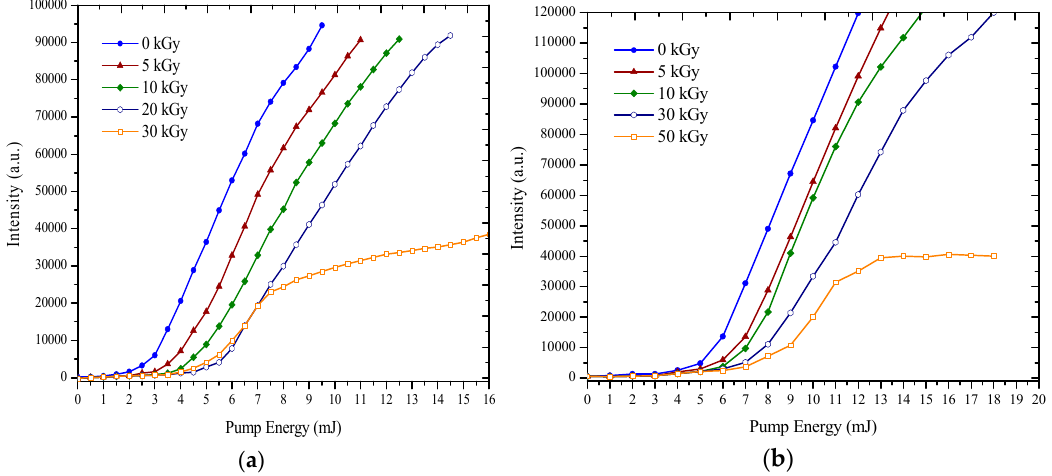
Figure 6. Cont. Figure 6. ( a ) The relationship between Pump Energy (mJ) vs. Intensity (a.u.) for MEH–PPV in THF at a 50 μ M concentration for different dose ranging from 5 to 30 kGy; ( b ) The relationship between Pump Energy (mJ) vs. Intensity (a.u.) for BMP in THF at 5 mM concentration for different dose ranging from 5 to 50 kGy. Table 1. ( a ) The details of BMP fluorescence, ASE peak wavelength (nm), peak intensity (a.u.), and blue shift occurring due to gamma radiation and full width half maximum (FWHM) of ASE when pump energy was 11 mJ; ( b ) The details of MEH–PPV fluorescence, ASE peak wavelength (nm), peak intensity (a.u), and blue shift occurring due to gamma radiation and full width half maximum (FWHM) of ASE when pump energy was 8 mJ. BEHP- co -MEH–PPV Fluorescence Dose kGy Peak intensity (a.u.) peak